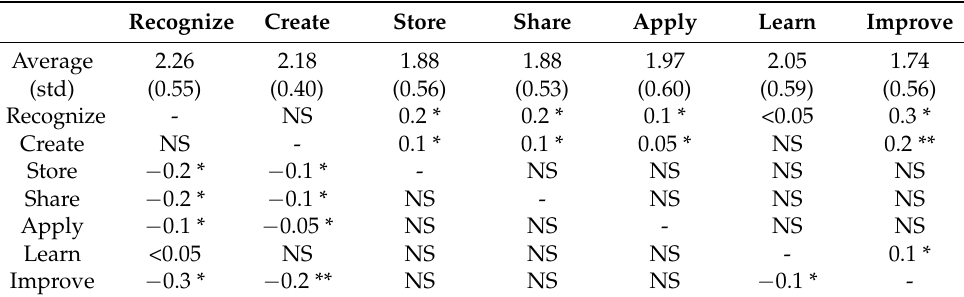
Table 3. Differences between phases’